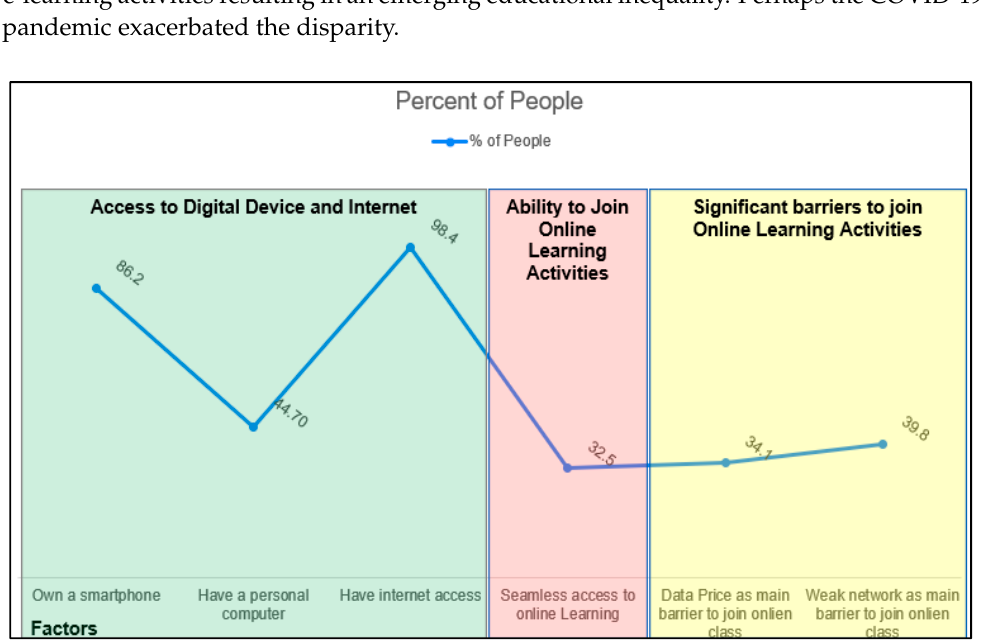
Figure 2. Access to a digital device, joining the online class, and the barrier to seamless access.